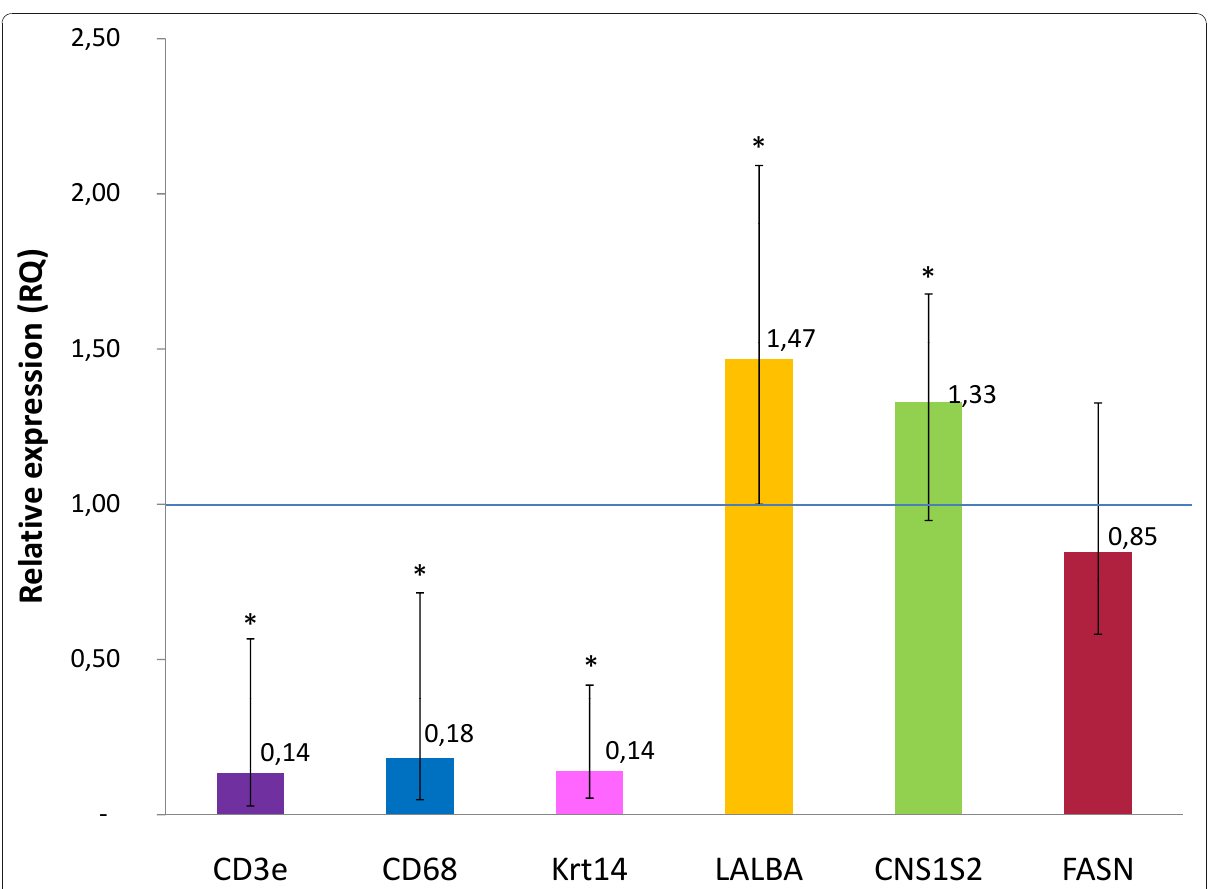
Figure 4 Selectivity of MEC capture assessed by real-time quantitative PCR . To estimate contamination of the laser-captured MEC by adjacent MMC as well as by immune cells (macrophages and lymphocytes) mRNA transcript levels of cell-specific markers were assessed by measuring the relative expression of the relevant genes between captured cells and mammary tissue scrapes, i.e. the mammary tissue remaining on slides, after LCM. Relative quantities of specific markers from MMC ( Krt14 ), macrophages ( CD68 ), lymphocytes ( CD3e ) and MEC ( CSN1S2 , LALBA ) were assessed after normalization ( PPAI and/or RPS24 ). FASN , a gene expressed in a large panel of cell types, including adipocytes and MEC, was also assessed in the same conditions. Mean RQ values are given for each gene. Krt14 decreased (RQ = 0.14; ca . 7-folds reduction) in the captured cells compared with the whole mammary tissue. Likewise the same ratio was observed with CD68 (RQ mean = 0.18) and CD3e (RQ mean = 0.14). Levels of LALBA (RQ mean = 1.47 fold), CSN1S2 (RQ mean = 1.33 fold) were significantly increased. *indicates ratio significantly different between cap and scraped tissue ( p <